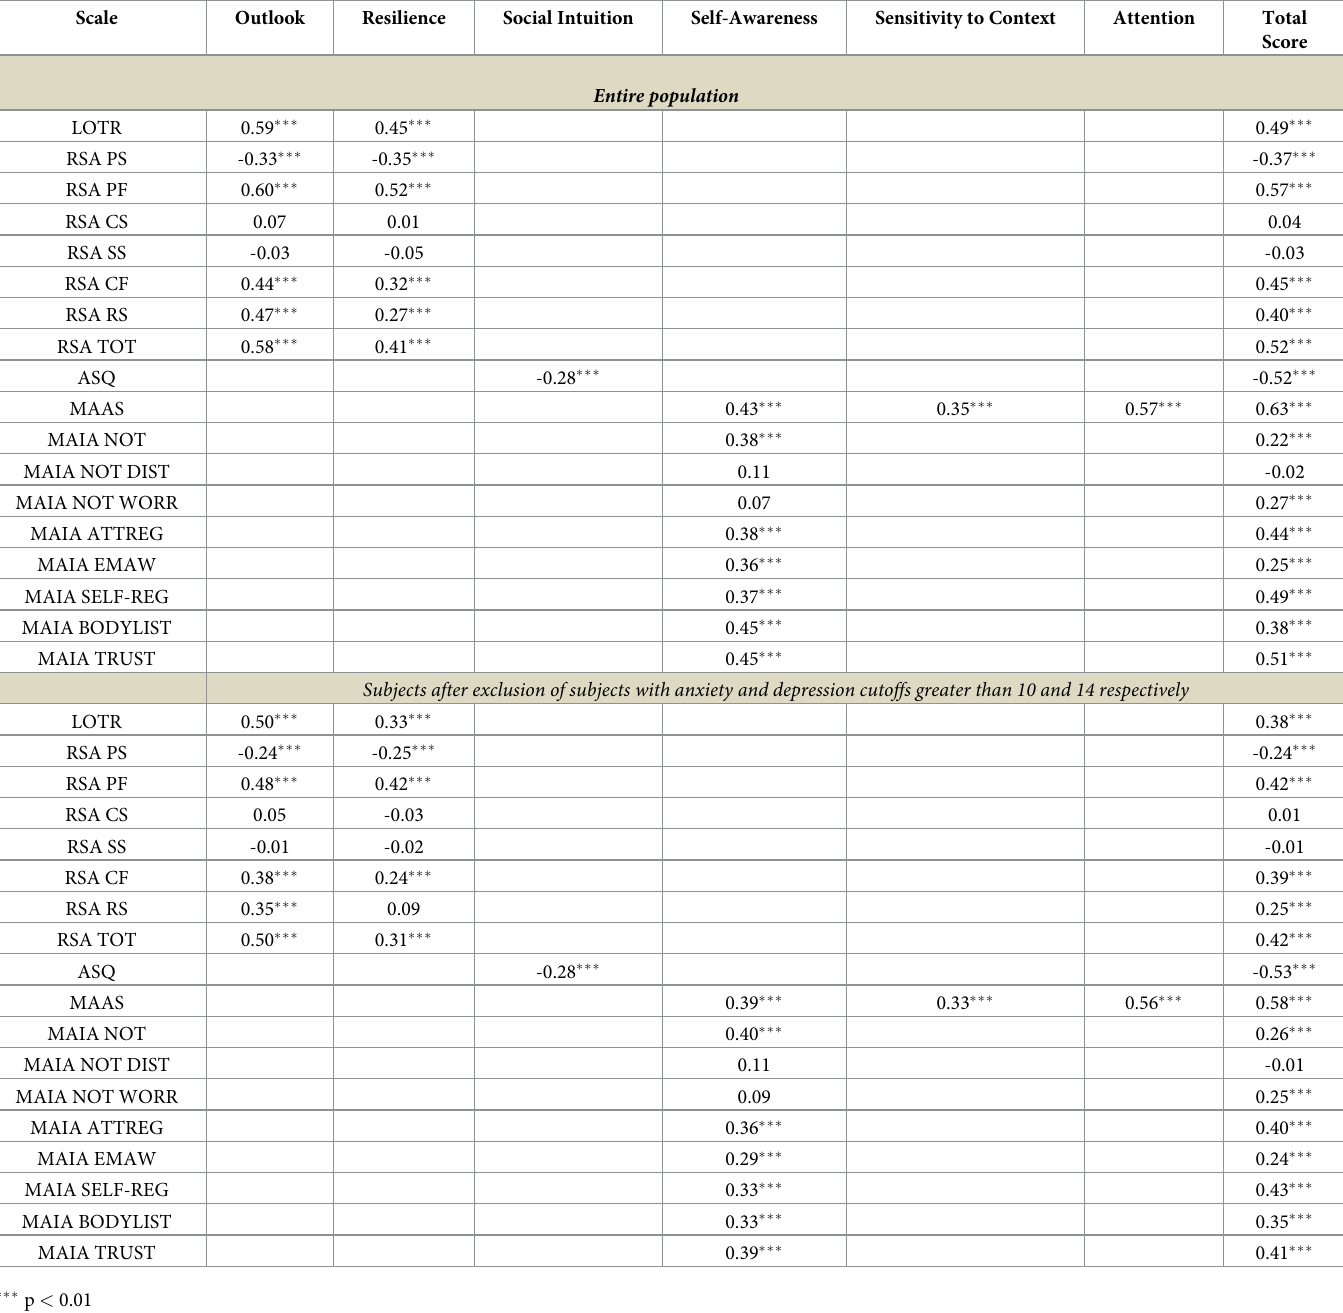
Table 4. Study 2 Spearman’s rank correlation